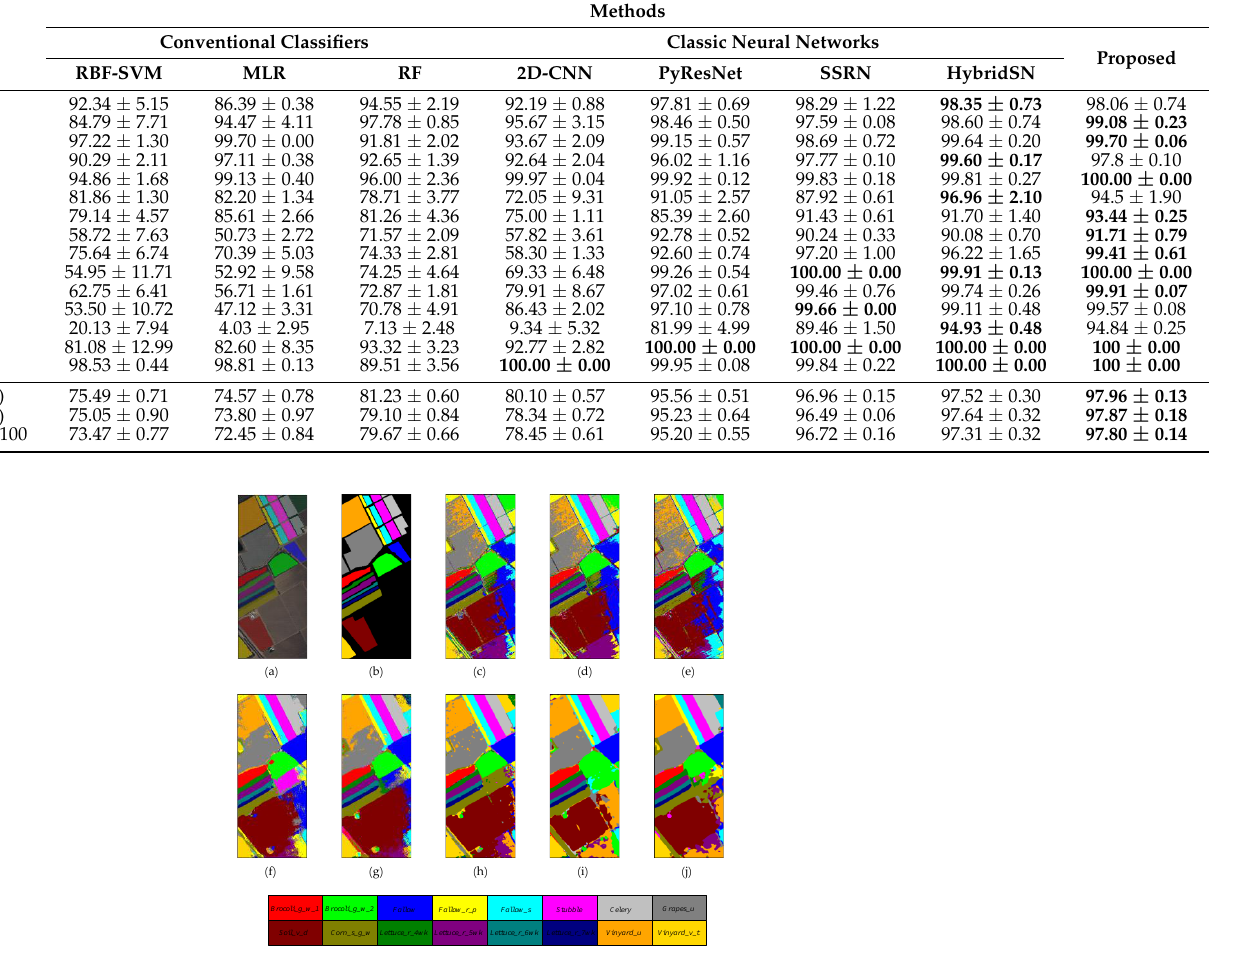
Figure 10. The classification maps of different methods on Salinas Valley dataset. ( a ) False color map with truth labels, ( b ) ground truth, ( c ) RBF-SVM, ( d ) MLR, ( e ) RF, ( f ) 2D-CNN, ( g ) PyResNet, ( h ) SSRN, ( i ) HybridSN, and ( j ) proposed.